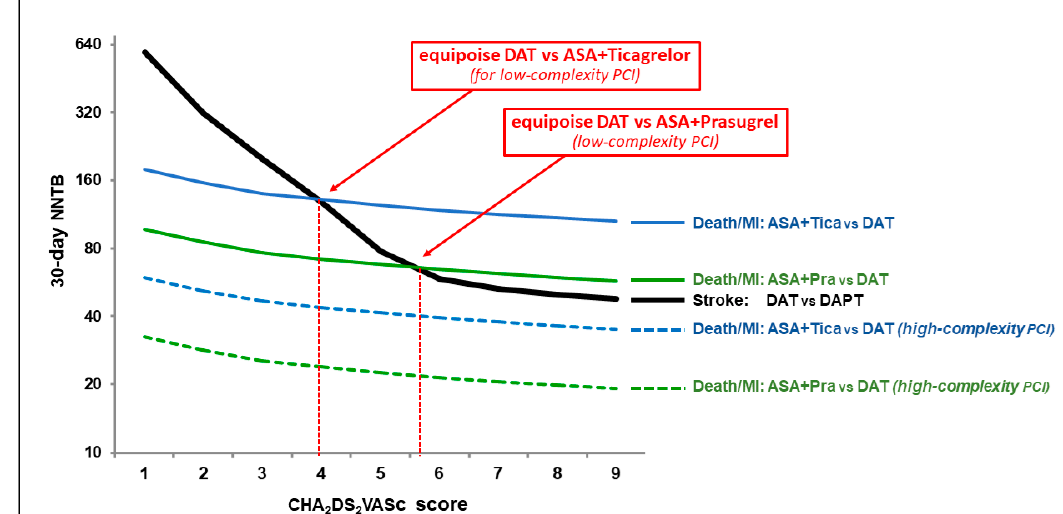
Figure 4. Calculated comparative numbers needed to treat and to prevent stroke or coronary events at 30 days for various antithrombotic drug combinations in patients with atrial fibrillation and a recent coronary stenting for an acute coronary syndrome. NNTBs for coronary events deriving from the use of DAPT with ticagrelor instead of DAT with clopidogrel appear to be lower than the NNTBs for stroke deriving from the use of DAT instead of DAPT for CHA 2 DS 2 VASc scores < 4. NNTBs for coronary events deriving from the use of DAPT with prasugrel instead of DAT with clopidogrel appear to be lower than the NNTBs for stroke deriving from the use of DAT instead of DAPT for CHA 2 DS 2 VASc scores < 5. In case of high-complexity PCI, the event ratio favors DAPT with both ticagrelor and prasugrel at any CHA 2 DS 2 VASc score. See the Online Appendix of [15] for calculations of different 30-day NNTBs comparing different antithrombotic strategies. Complex PCI is defined as at least three of the following features: long, bifurcated, eccentric, thrombotic, tortuous, angulated or calcified lesions, left main PCI, and multiple vessel PCI [16]. Abbreviations: ACS: acute coronary syndrome; DAPT: dual antiplatelet therapy (aspirin + clopidogrel); DAT: dual antithrombotic therapy (an anticoagulant plus a P2Y 12 inhibitor antiplatelet therapy); NNTB: number needed to treat for benefit; OAC: oral anticoagulation; PCI: percutaneous coronary intervention.